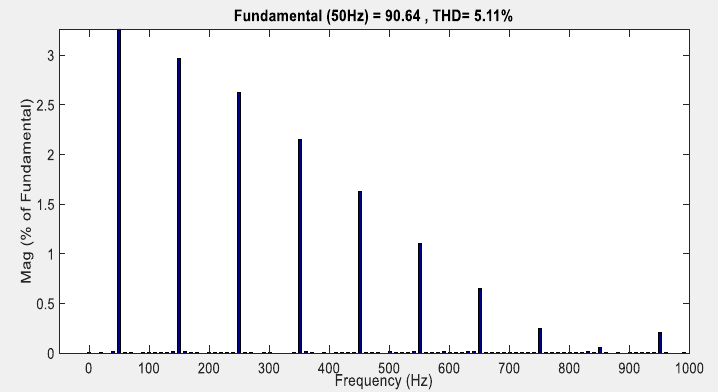
Figure 14. Simulation waveforms of grid voltage and input current under unity power factor.